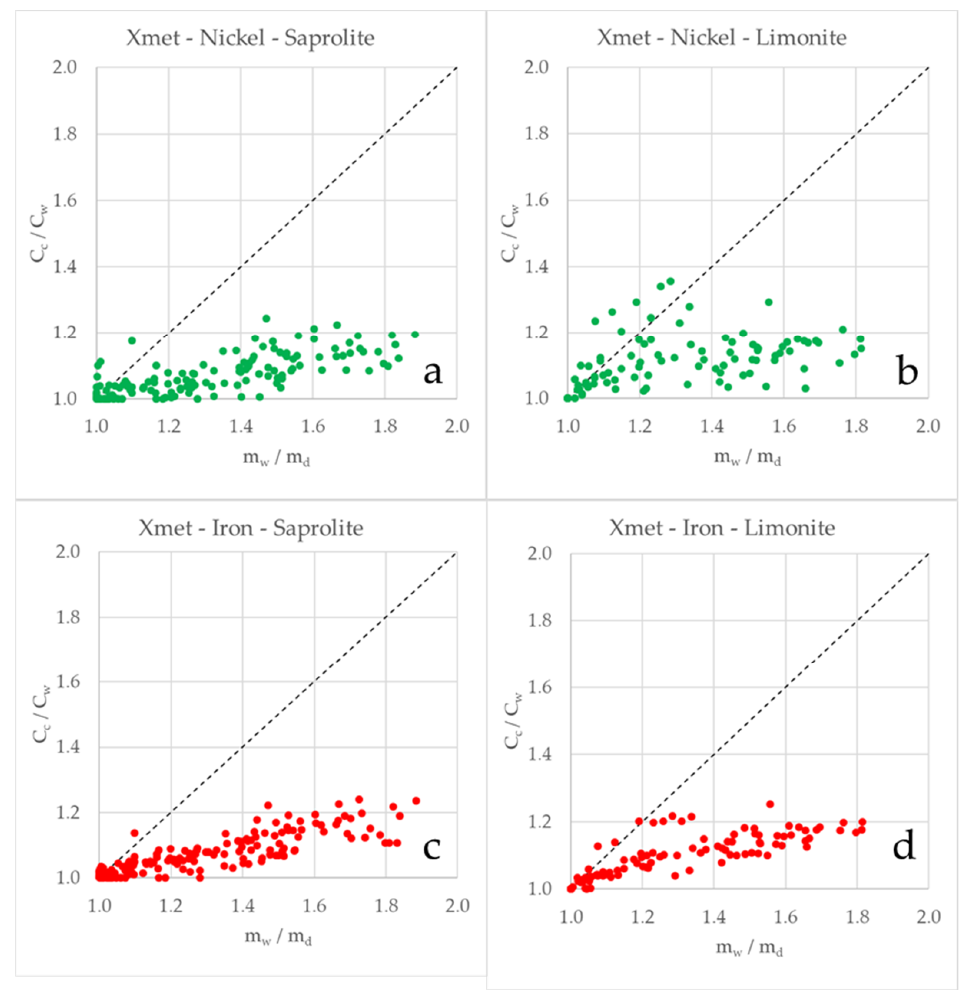
Figure 11. Data from the Xmet after correction with the dilution law: ( a ) Ni in the saprolite layer; ( b ) Ni in the limonite layer; ( c ) Fein the saprolite layer; ( d ) Fe in the limonite layer. If the situation was totally ideal (dilution law fully adapted and no sample preparation and measurement errors), all the points should be located on the dashed line